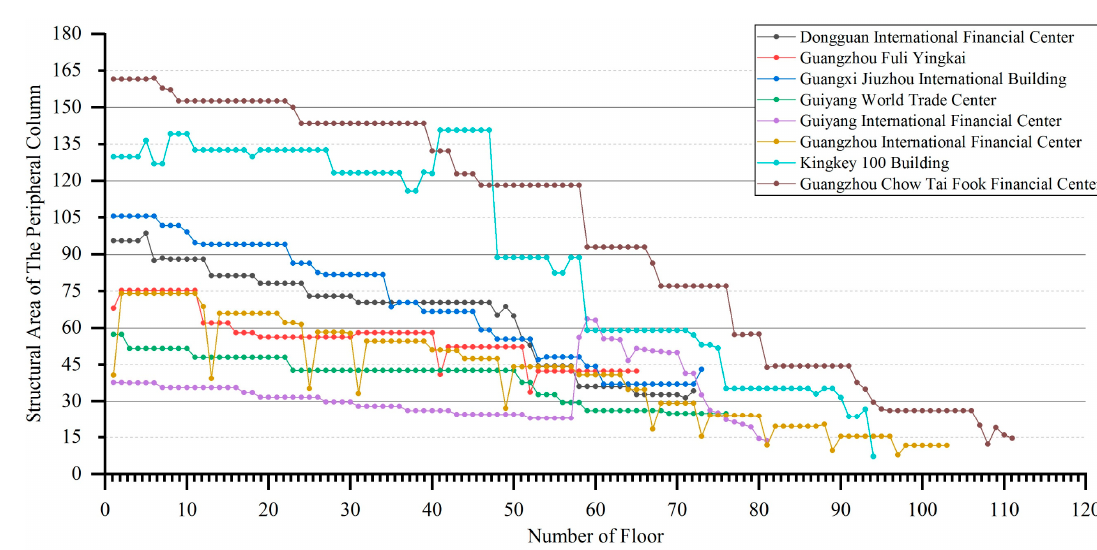
Figure 18. The structural area of the peripheral column. Table 7. Dimensions of structural components of Guangzhou International Financial Center.